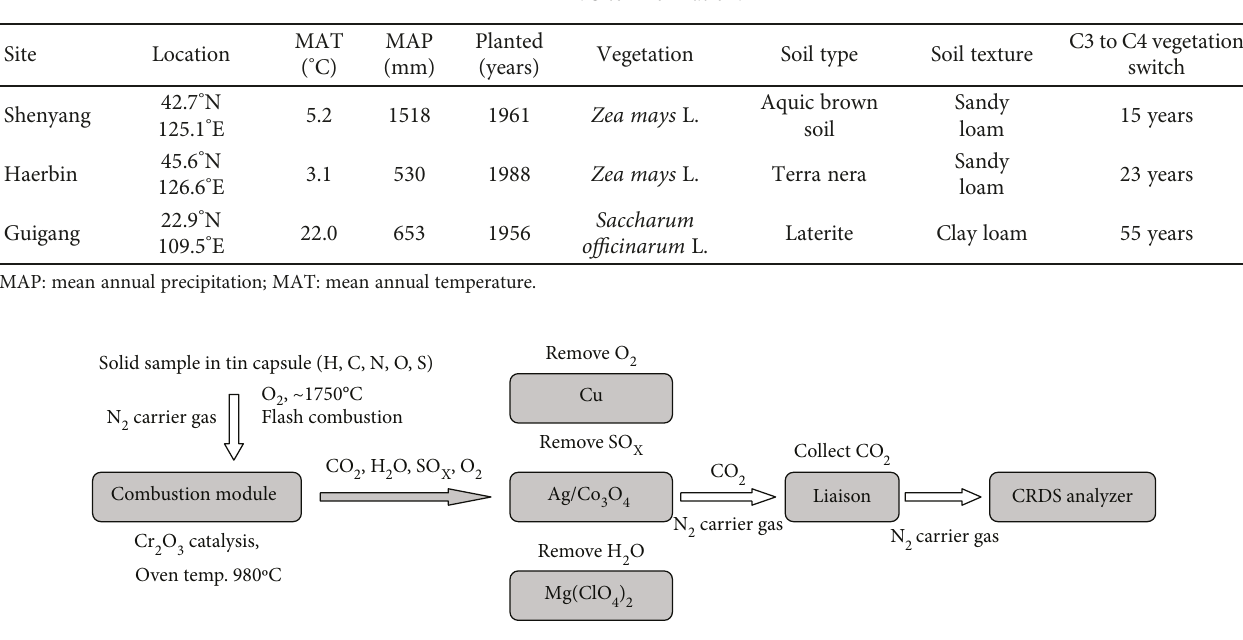
Figure 1: Schematic representation of the experimental setup for CM-CRDS